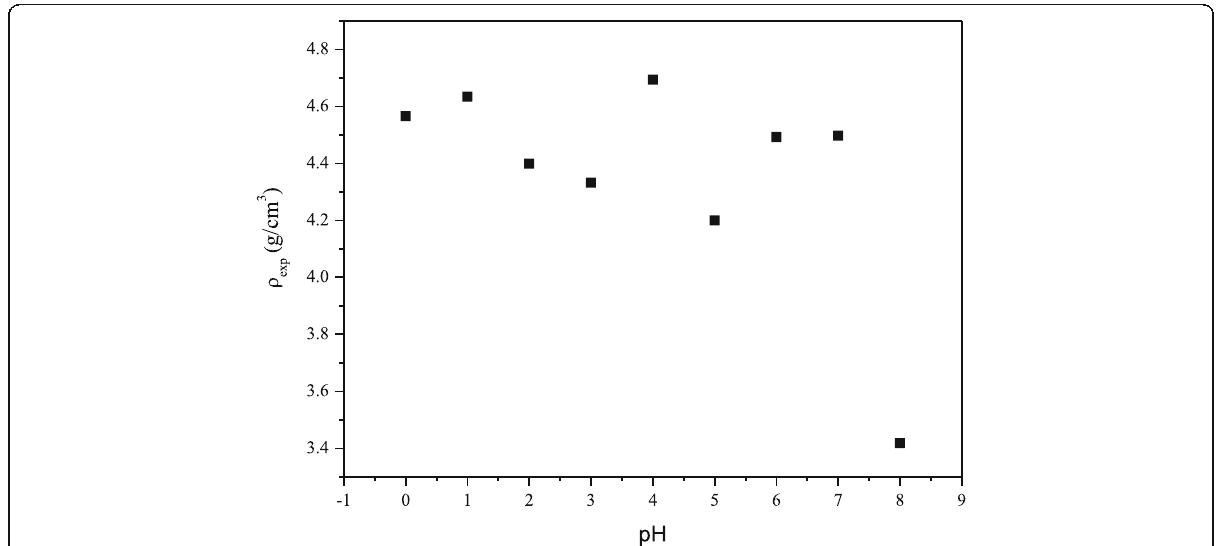
Fig. 4 Experimental density of SrFe 12 O 19 nanoparticles for pH 0 to pH 8, sintered at 900